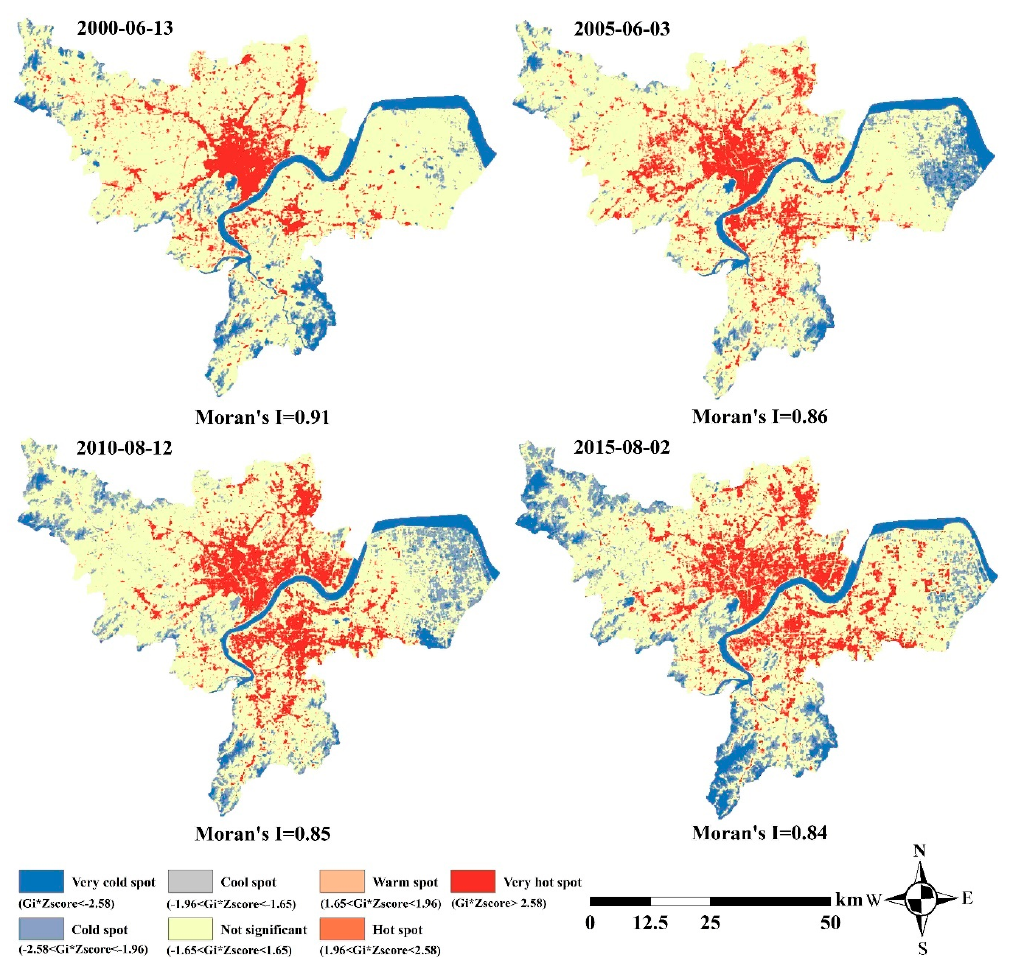
Figure 3. Spatial distribution of hot and cold spots in the HMA during 2000 – 2015.